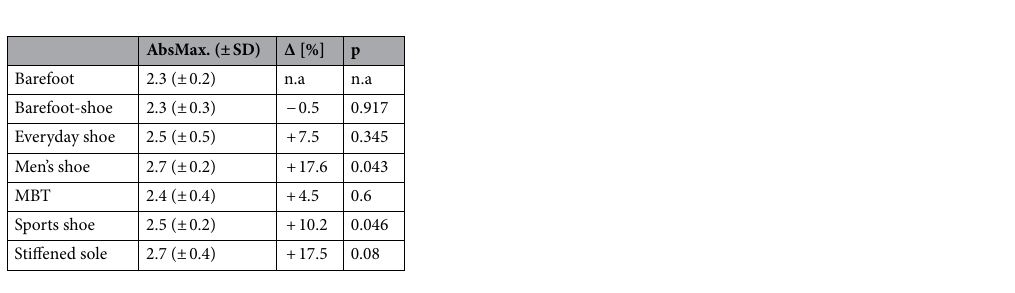
Table 4. Torsion moment M tors and the deltas [%] in relation to barefoot walking at 4 km/h; AbsMax absolute maximum, SD standard deviation, MBT